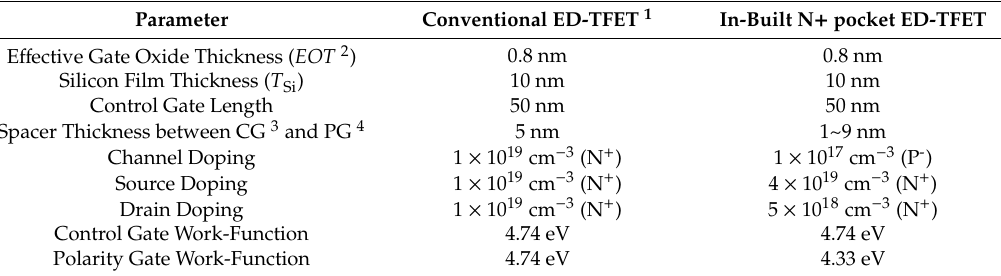
Table 1. Parameters used for device